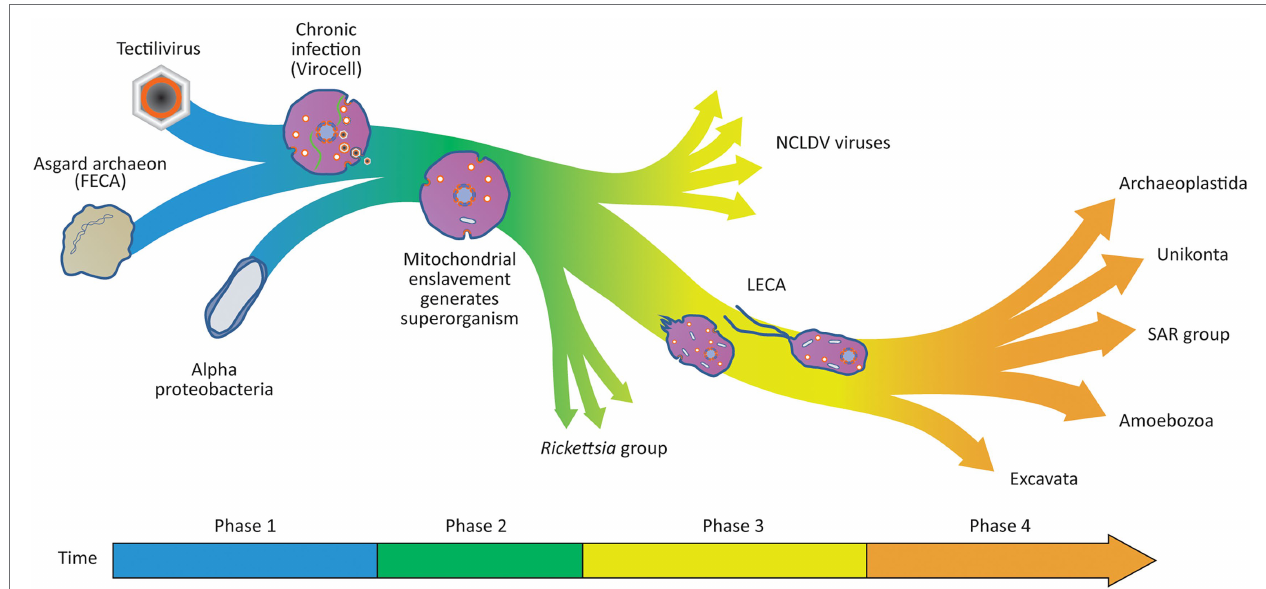
FIGURE 6 | Viral Eukaryogenesis model for the origin of the eukaryotic cell. In Phase 1 of the eukaryogenesis process, the chronic infection of an Asgard host results in the generation of a virocell. Within the virocell, the viral factory introduces a separation of transcription from translation and several other eukaryotic features that contribute to its future potential to evolve complexity including an endomembrane system and a dynamic cytoskeleton. In Phase 2 of the eukaryogenesis process, an alpha-proteobacteria evolves to infect the virocell through the vesicle system that allows the Tectilivirus to chronically infect the archaeal host. The rare and defining step of eukaryogenesis occurs when the viral factory enslaves one of the bacterial parasites converting the virocell into a three-component superorganism with emergent properties. The enslaved endosymbiont produces energy and raw materials to sustain the viral factory in the host cell, making it advantageous for the virus and endosymbiont to be located in the same cell. In Phase 3 of the eukaryogenesis process, there is a continuing transfer of genes from the enslaved endosymbiont to the viral genome as it takes over complete control of the endosymbiont’s metabolism. A similar process results in the transfer of a complete translation apparatus and basic metabolism from the host archaeon to the viral genome. During this process, the superorganism evolves the ability to differentiate into an amoeboid predator when prey is abundant, and a flagellated motile form to allow dispersion and infection of new hosts. By the time LECA appears, only 69 genes remain in the endosymbiont genome, and the archaeal host genome is completely lost, resulting in a protozoan-like eukaryotic predator. In Phase 4, phagocytosis allowed the superorganism to become an amoeba-like predator that also possessed a unique mode of evolution introduced by the sexual cycle. This led to an evolutionary arms race selecting for larger and more complex eukaryotic organisms resulting in the evolution of the diverse range of eukaryotes observed today. Unlike the origin of LECA as a superorganism, the evolution of the eukaryotes after the appearance of LECA is well described by the neo-Darwinian synthesis, and thus, a tree metaphor is a useful description of the relationships between all members of the eukaryotic